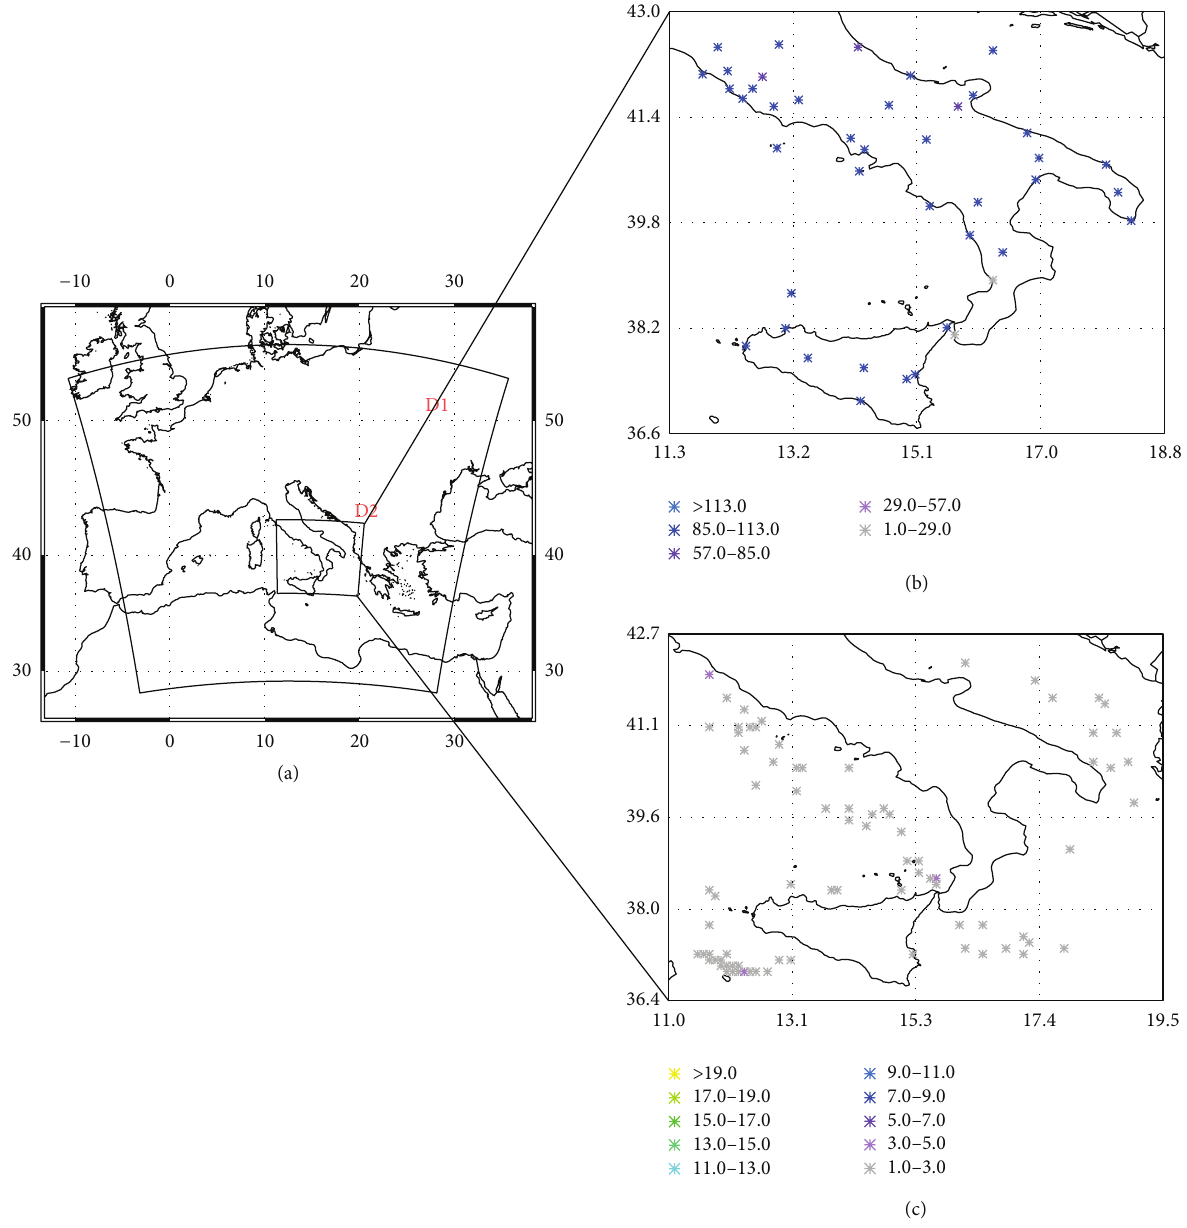
Figure 1: (a) RAMS domains: (b) SYNOP land stations over the second domain. The colours of the stations show the reports multiplicity for spring 2013 and for the 18 hours of forecasting time and (c) SYNOP mobile stations over the second domain. The colours of the stations show the reports multiplicity for spring 2013 and for the 60 hours of forecasting time. The positions and number of the mobile reports change with